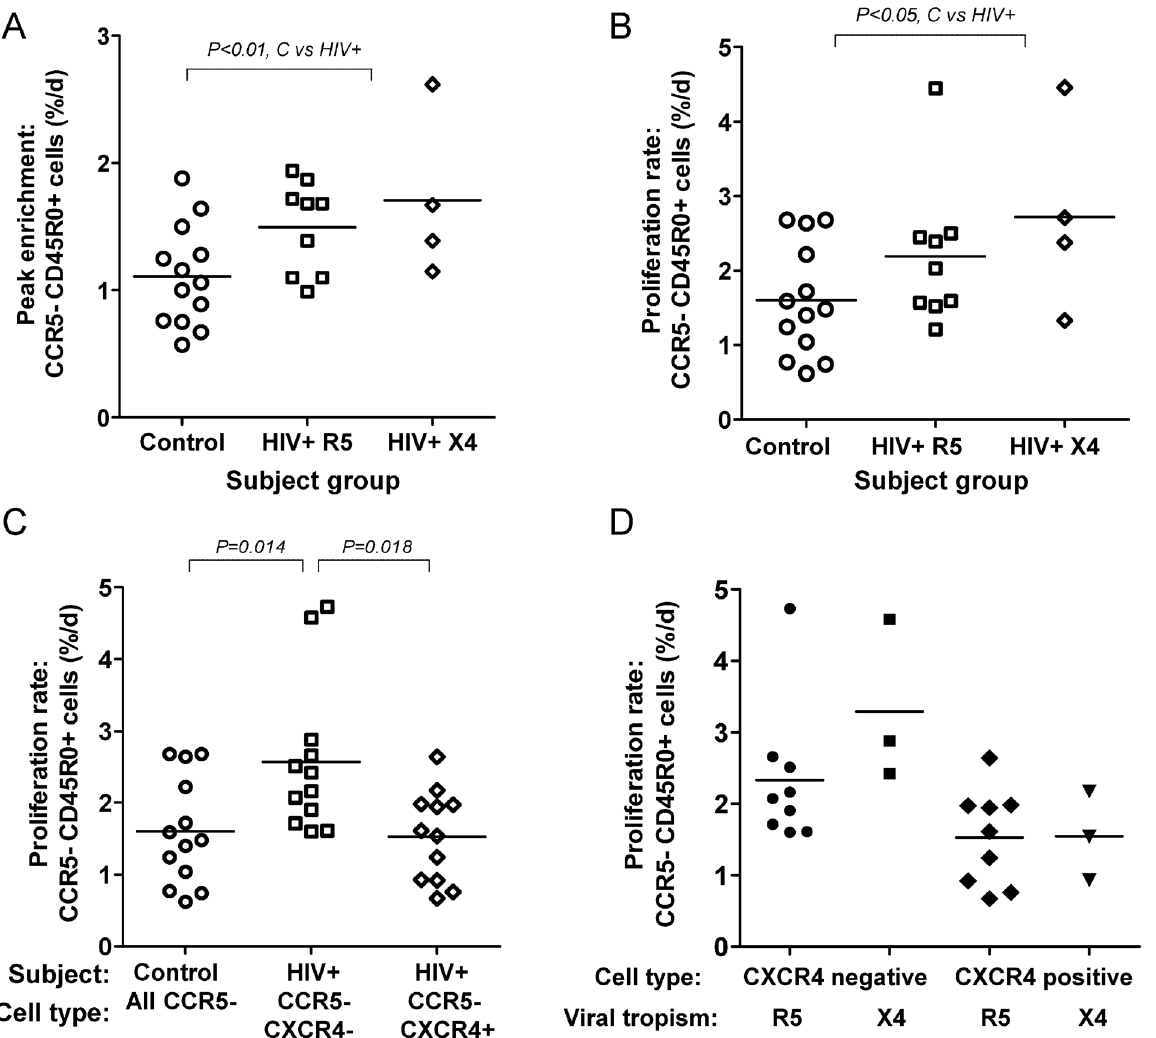
Figure 3. HIV infection increases turnover rates of CCR5-negative CD4 + CD45R0 + memory T-cells. HIV infection and turnover rates of CCR5 2 memory T-cells, expressed either as peak enrichment (A) or modeled proliferation rate (B) for all CD4 + CD45R0 + CCR5 2 cells, according to subject group: HIV + R5, HIV-positive subjects with R5-tropic virus; HIV + X4, HIV-positive subjects with X4-tropic virus. When CCR5 2 cells in HIV + subjects were subdivided by CXCR4 expression (C), the effect of HIV infection was found to be confined to the CXCR4 2 compartment; x-axis separated by subject group and cell type; control samples were not subdivided by CXCR4 expression. (D) Relationship between proliferation rates, CXCR4 expression and viral tropism in CD4 + CD45R0 + CCR5 2 cells in HIV +